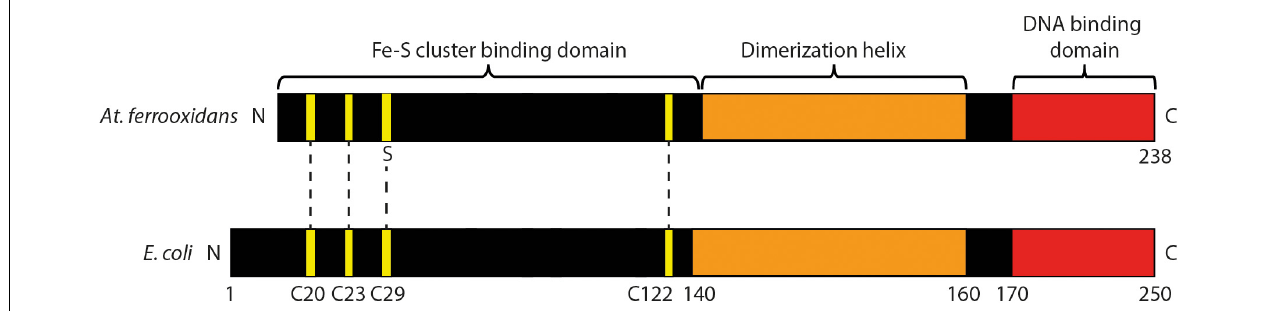
FIGURE 2 | Cartoon of predicted domain structure of FNR AF compared to FNR EC . The four cysteines that coordinate the [4Fe-4S] 2 + cluster at positions 20, 23, 29, and 122 in FNR EC (Mettert and Kiley, 2007) are highlighted in yellow. Three of these cysteines are conserved in FNR AF .